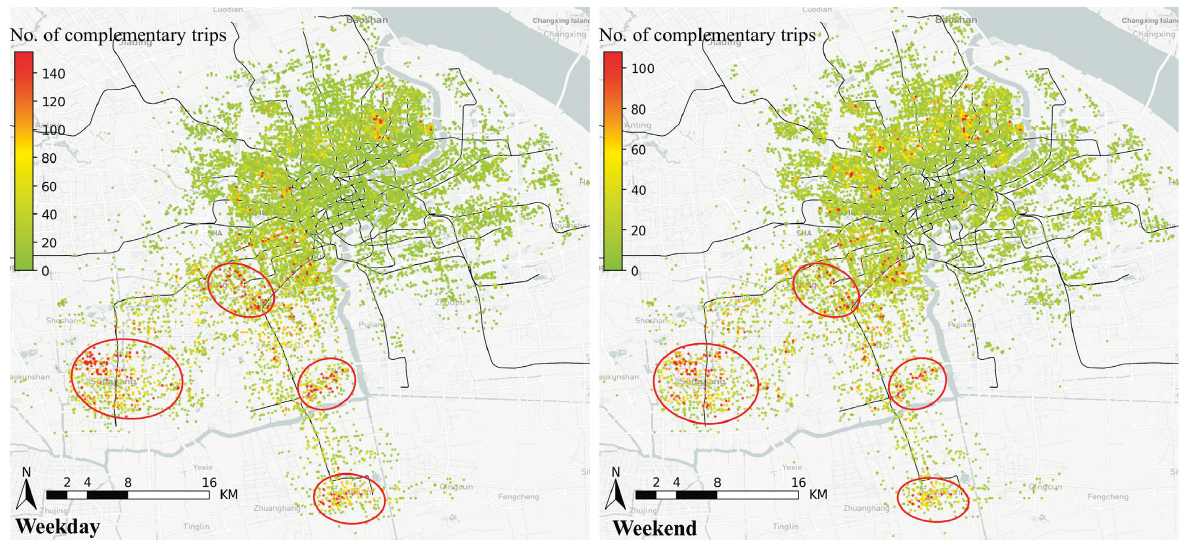
Figure 13: The demand of complementation trips.